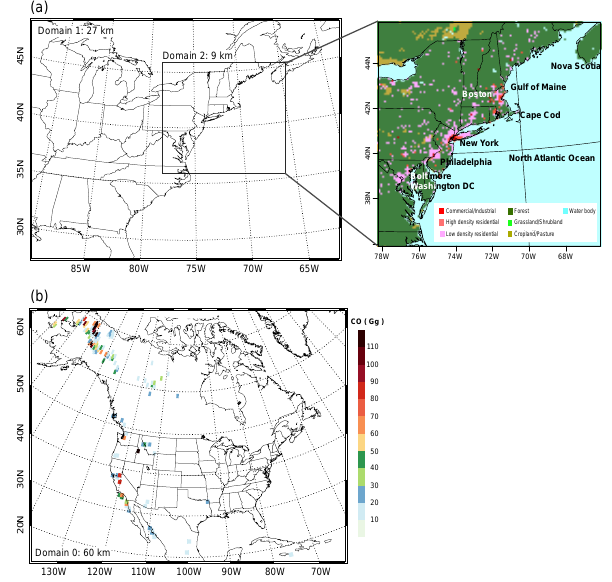
Fig. 2. (a) Configuration of WRF-Chem domains for control simu- lations. The coarse domain (domain 1) has a horizontal resolution of 27km (100 × 86 mesh), and the nested domain (domain 2) has a horizontal resolution of 9km (121 × 121 mesh). The nested domain 2 shows a spatial distribution of dominant land-use type based on the USGS (United States Geological Survey) land-use data for nat- ural surfaces and the NLCD (National Land Cover Dataset 2001) for three urban classes. (b) A larger WRF-Chem domain (domain 0) with a horizontal resolution of 60km (135 × 115 mesh) designed to provide chemical initial and boundary conditions for the 27km domain. A spatial distribution of total CO emissions from wildfires during the period of 12–19 July 2004 is